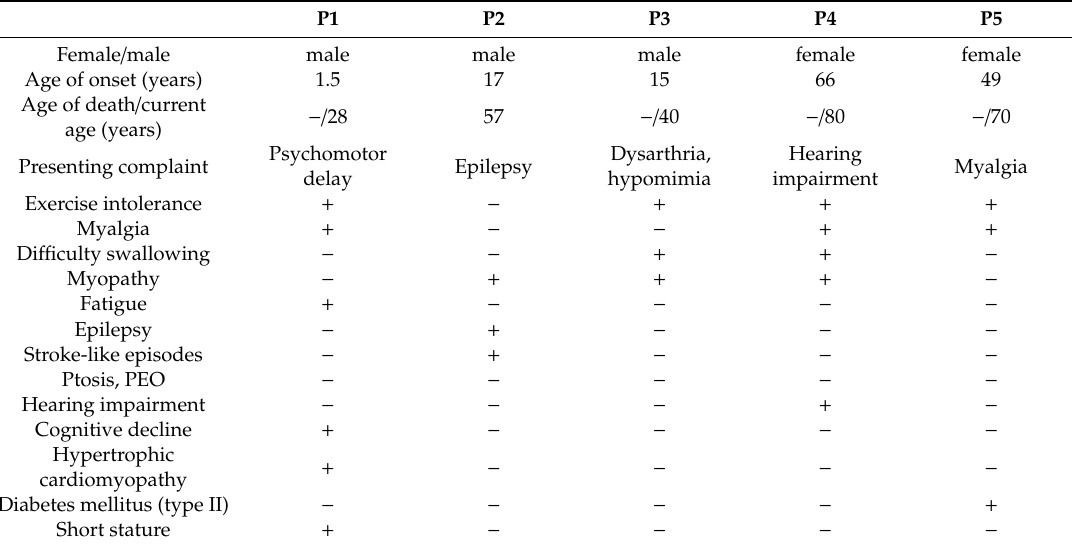
Table 3. Clinical features in patients with atypical